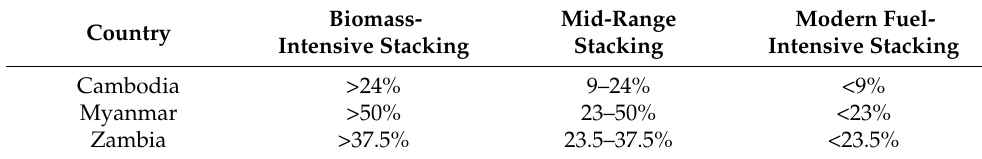
Table 3. Proportion of monthly fuel expenditure dedicated to biomass (not just for cooking).